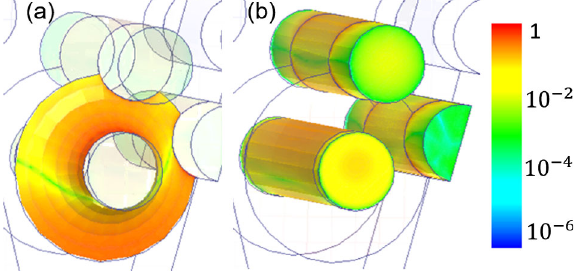
FIG. 8. The normalized electric field map (in log scale) of (a) the fillet, and (b) the inner three rods of the HPBG-d3 structure in simulation.